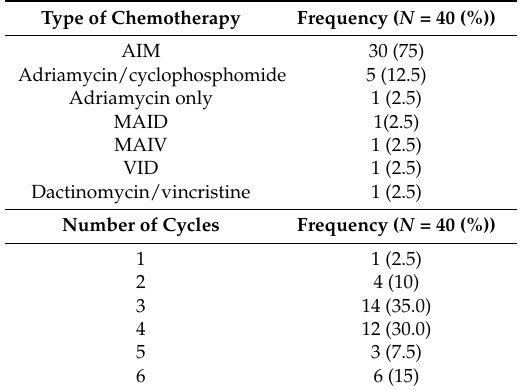
Table 5. Chemotherapy types and number of cycles received by patients with early-stage synovial sarcoma (A: adriamycin; I: ifosfomide; M: MESNA; V: vincristine; D: dactinomycin).